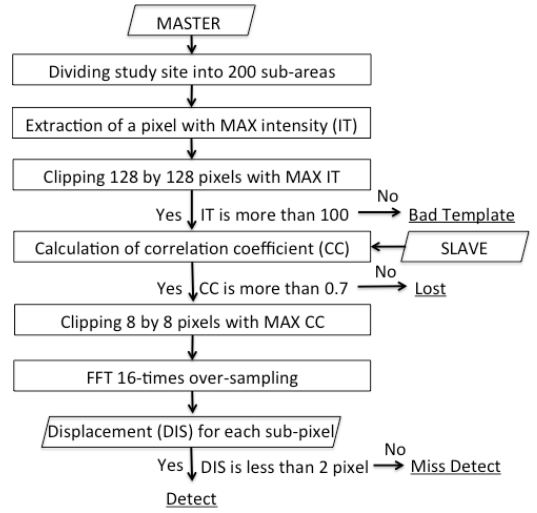
Figure 3. Procedure of pixel matching methodology to estimate the displacement with sub-pixel unit from the pair of TerraSAR- X